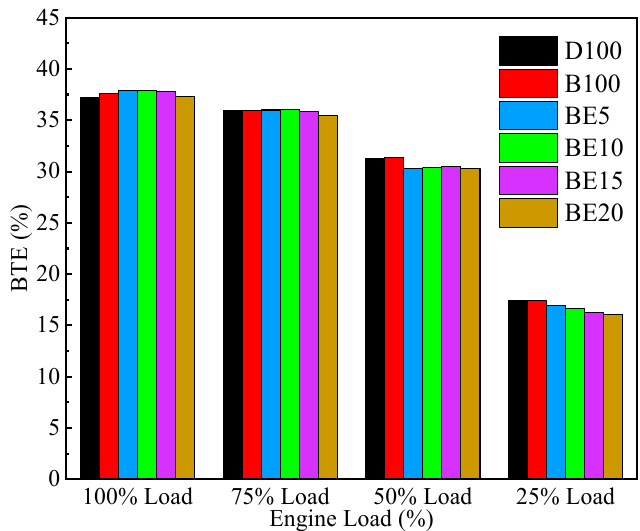
Figure 10. Comparison of BTE for different fuels at different loads.